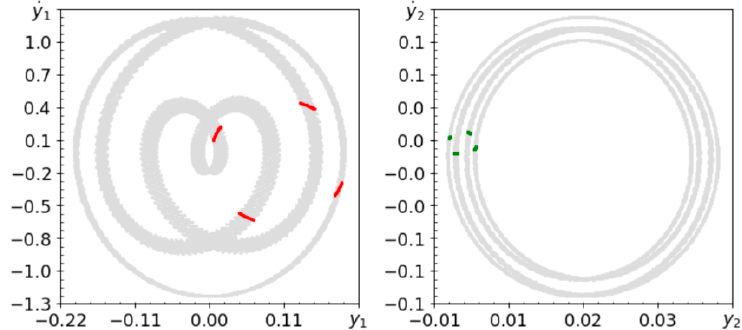
Figure 3. Phase planes (gray lines) and Poincaré maps (red and green dots) for (cid:2033) = 4.94 .